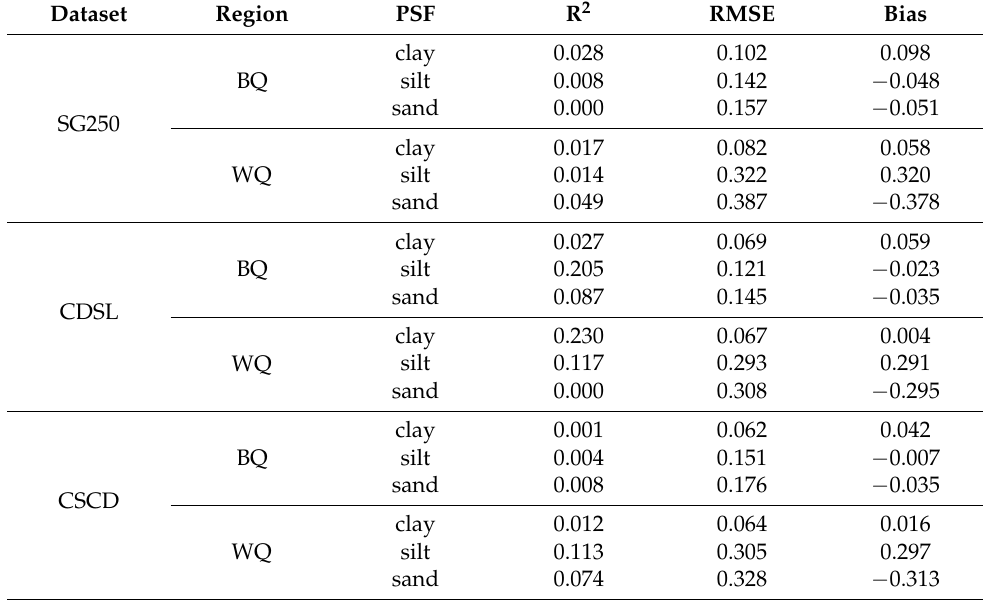
Figure 7. Spatial distribution of soil particle size fractions (PSFs) at the WQ region using ILR-RF and extracted from three soil datasets. Table 5. Assessment of soil PSFs extracted from SoilGrids250m (SG250), China dataset of soil properties for land surface modeling (CDSL), and China soil characteristic dataset